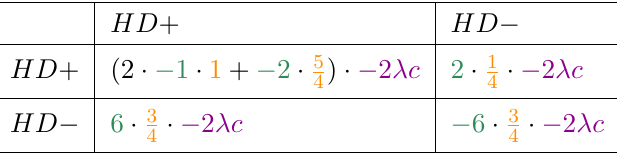
Table 12 . Phase space factors, given in green, can be found in appendix E.3 and are explained in section 3.1.1. Gauge factors, given in orange, can be found in tables 2, 13 and 14, and are explained in section